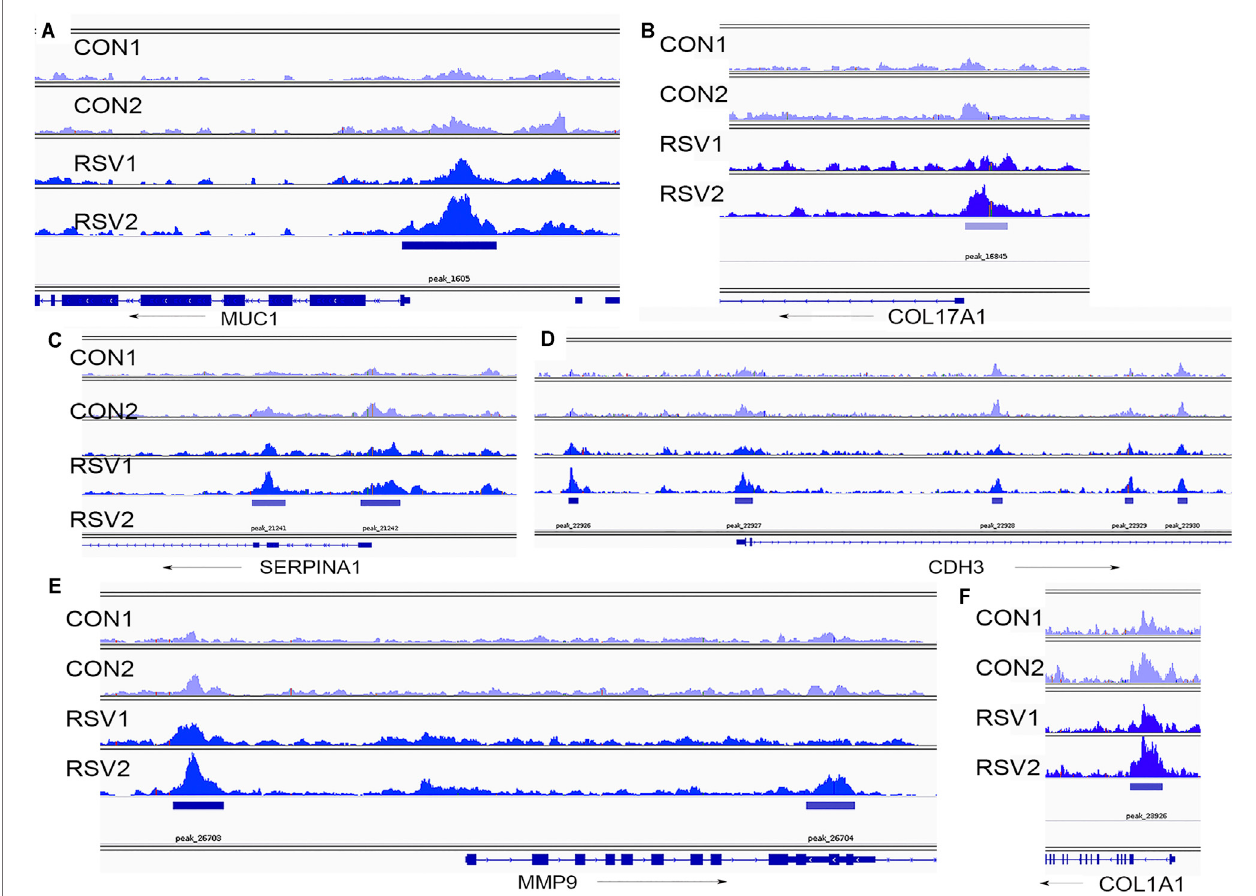
FIGURE 10 | Chromatin-accessible peaks in 5 ′ regions of BRD4-dependent genes. Shown are individual ATAC-Seq tracks for replicate control and RSV-infected cells (Xu et al., 2020). (A) , MUC1 locus; (B) , COL17A1 , (C) , SERPINA1 ; (D) , CDH3 ; (E) , MMP9 ; and (F) , COL1A1 . Direction of transcription is indicated by the